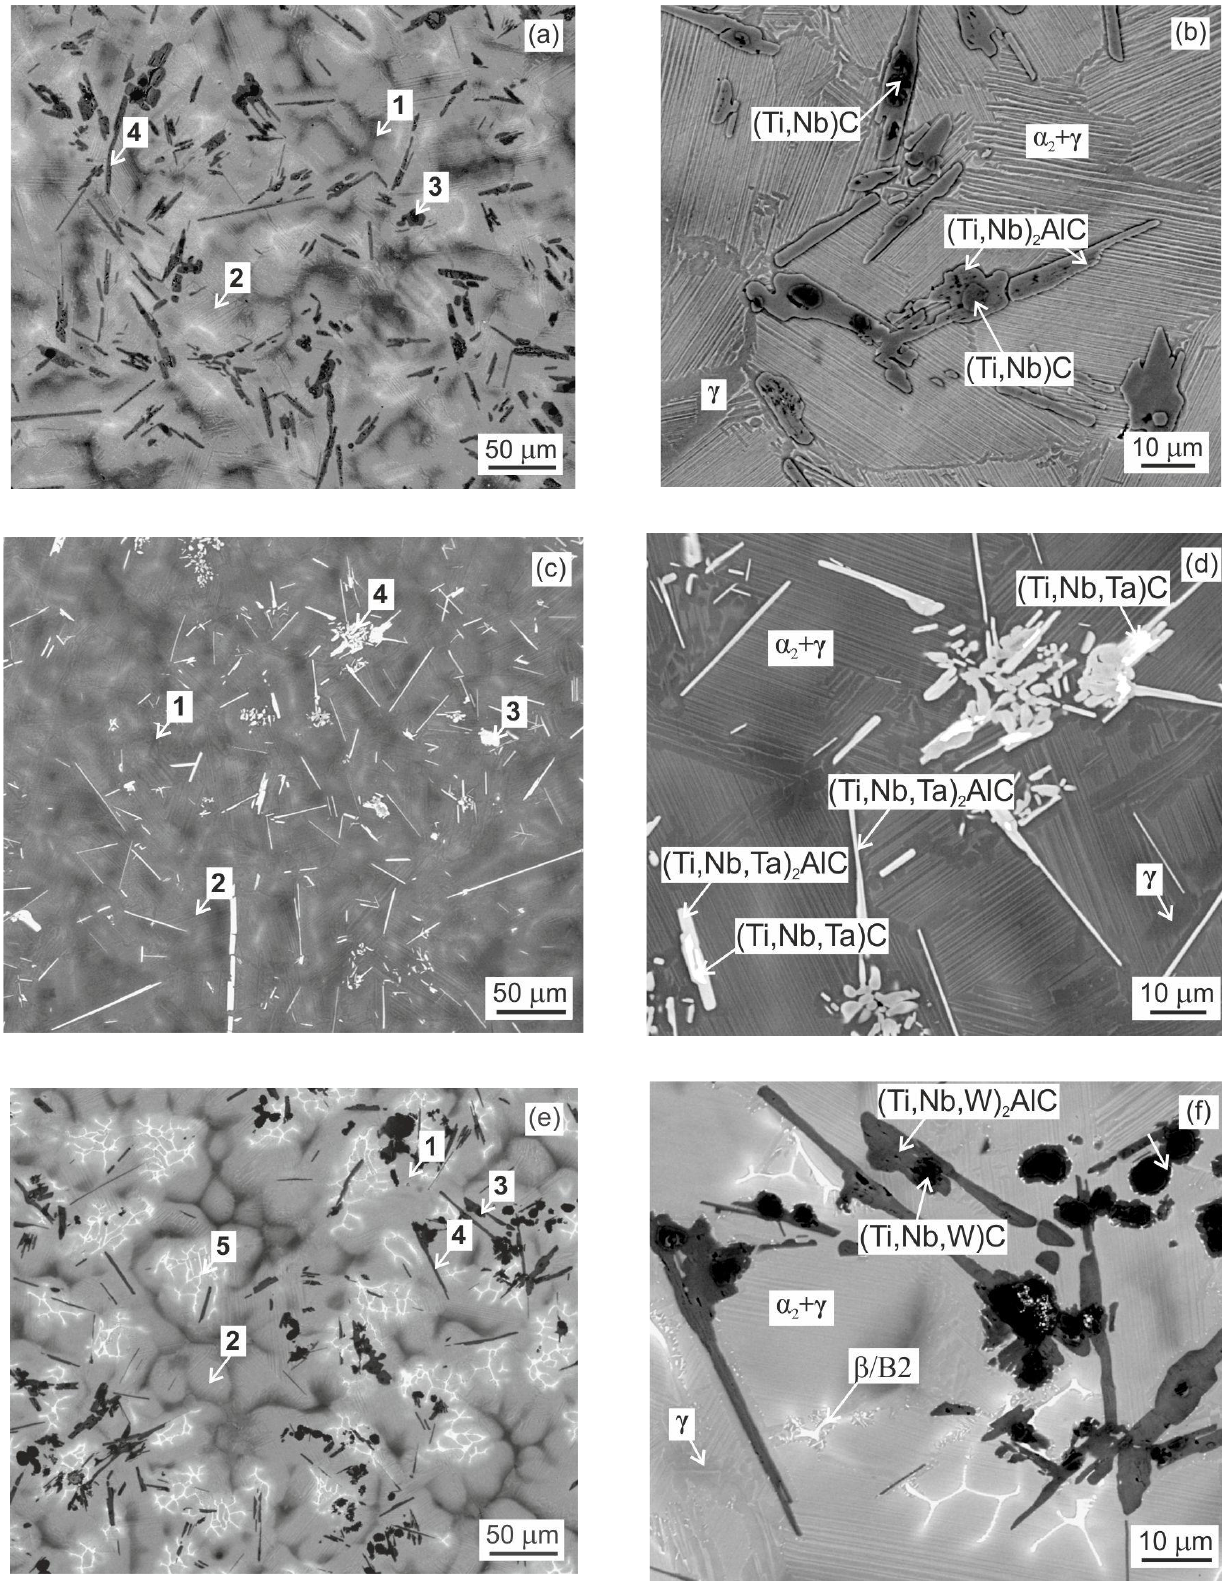
Figure 1. BSE micrographs showing the microstructure of tilt-cast alloys: ( a , b ) Nb, ( c , d ) NbTa, and ( e , f ) NbW.